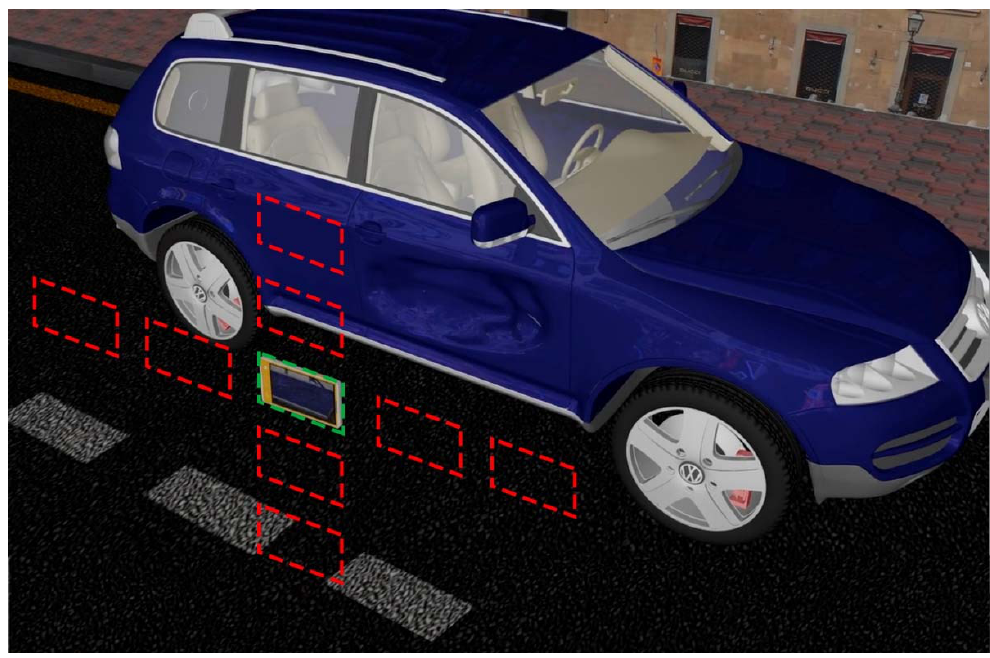
Figure 2. Photogrammetric data acquisition protocol based upon capturing between five and nine images of the part of the vehicle that has suffered an impact. The master image is in green, and the complementary photos are in red.